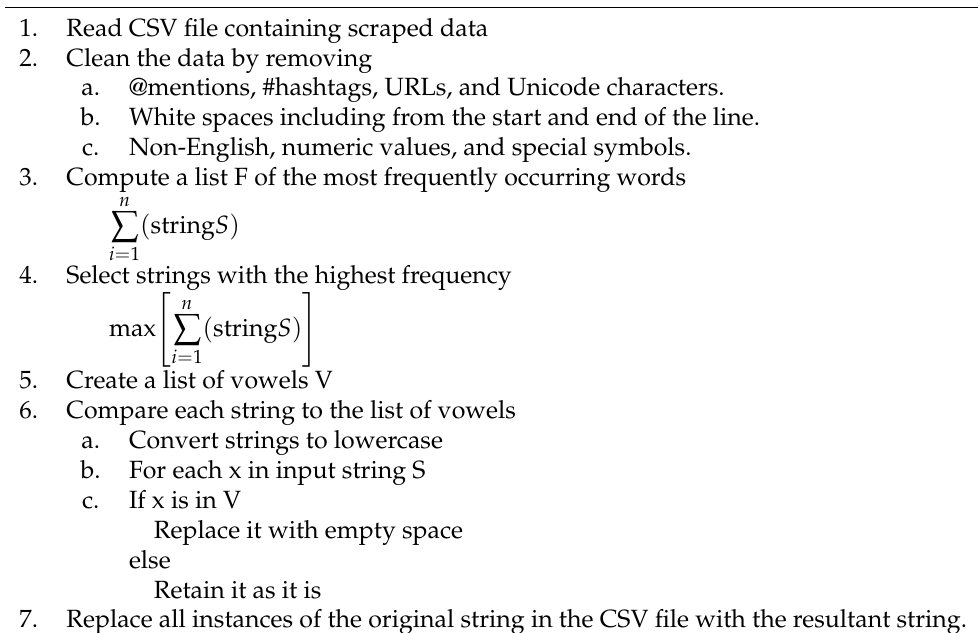
Algorithm 1: RU Lexical Unification by Removing Vowels.